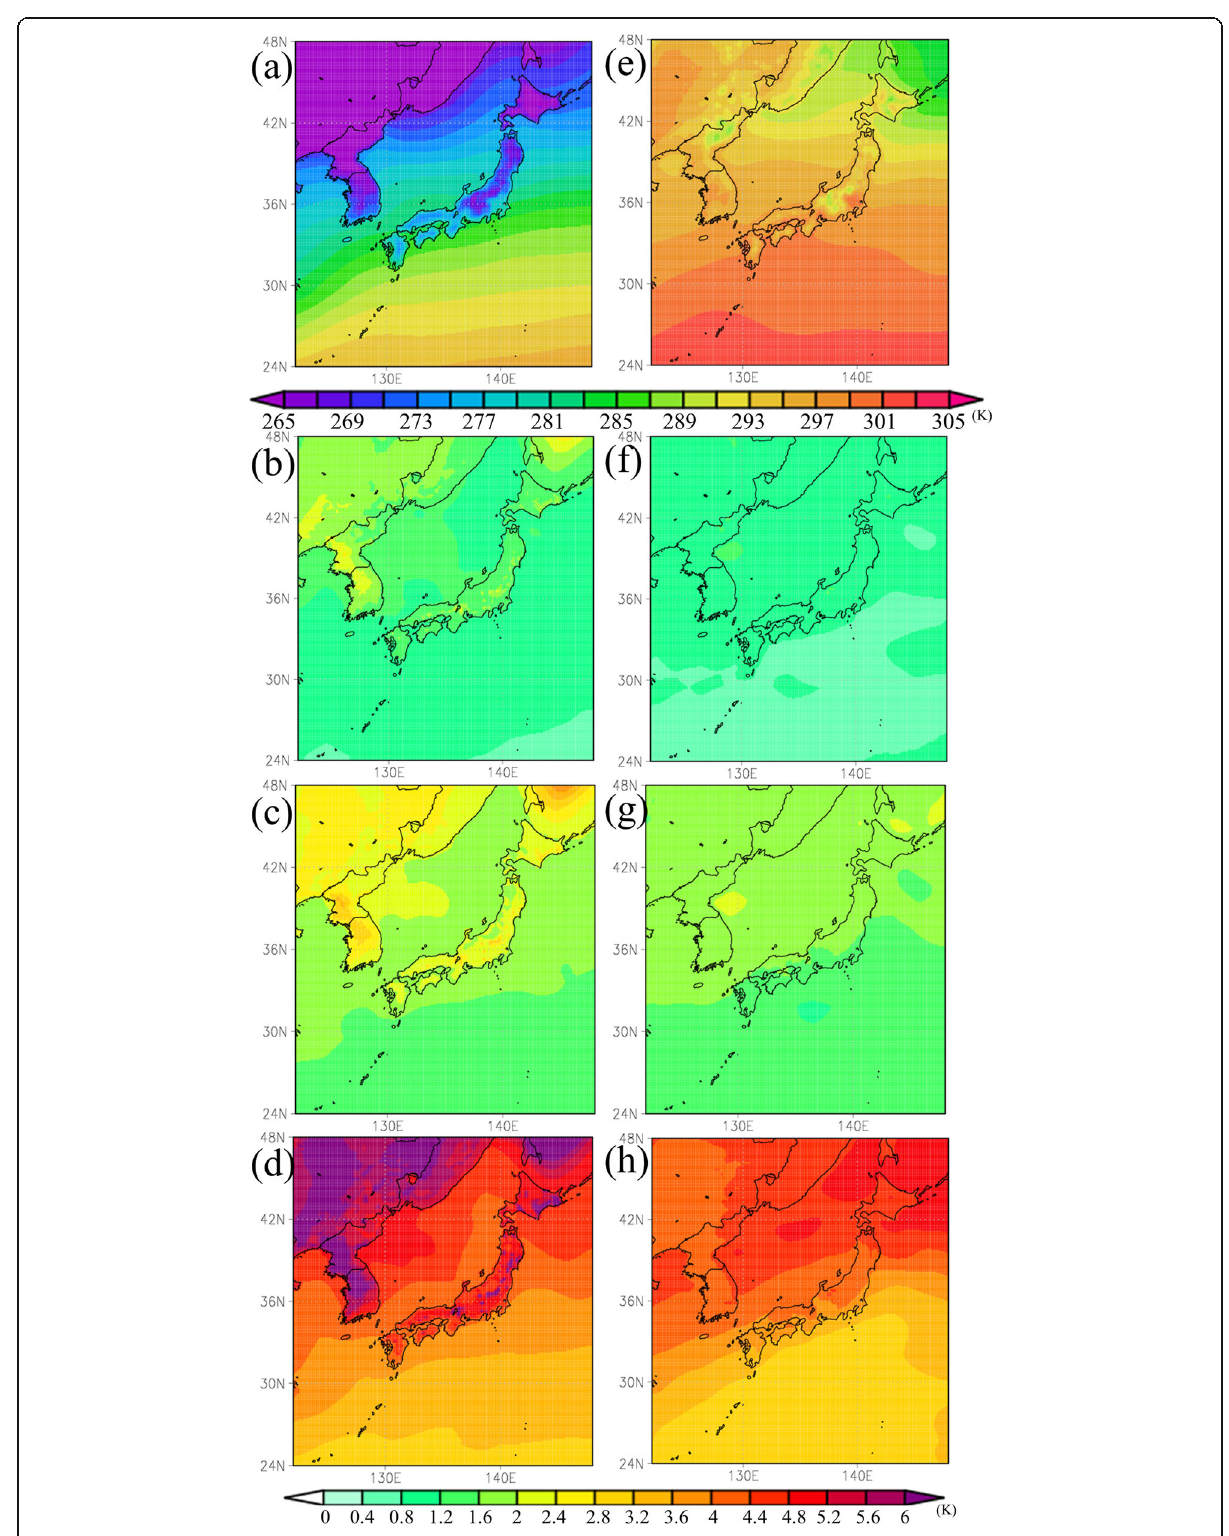
Fig. 4 Seasonal mean SATs and future SAT changes. Seasonal mean SATs (K) of PAST ( a and e ) and the future SAT changes of d1.5 ( b and f ), d2 ( c and g ), and d4 ( d and h ). Values for DJF and JJA are shown in the left and right columns, respectively. The mean values are based on 1450 years for PAST and 1566 years for the future